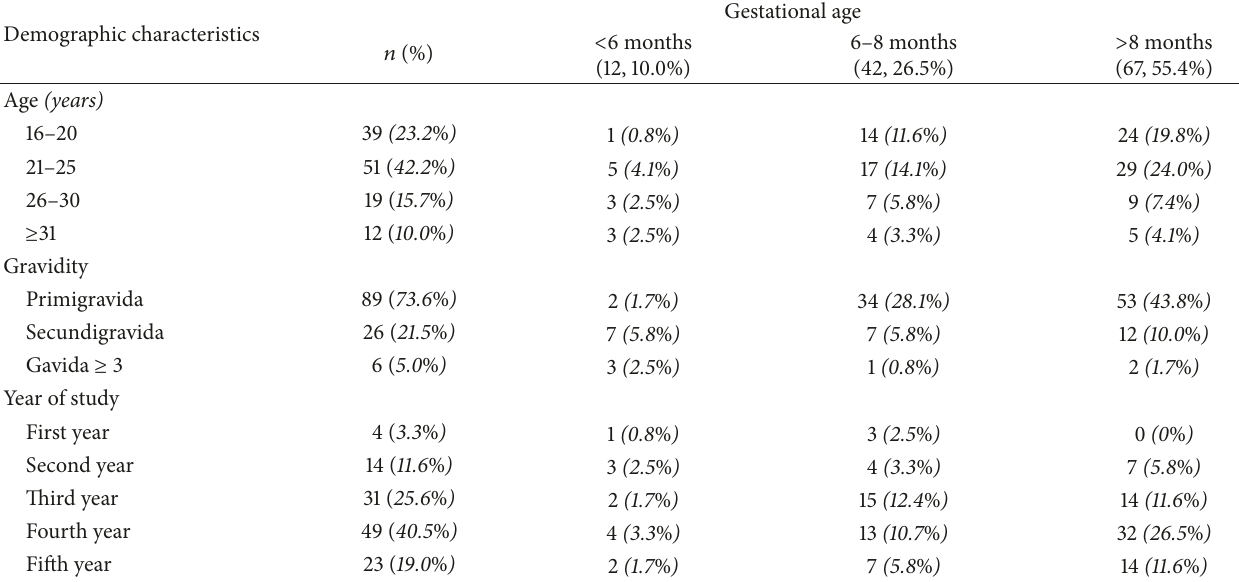
Table 1: Respondents’ characteristics and whether they have had malaria in their pregnancy 𝑛 = 121